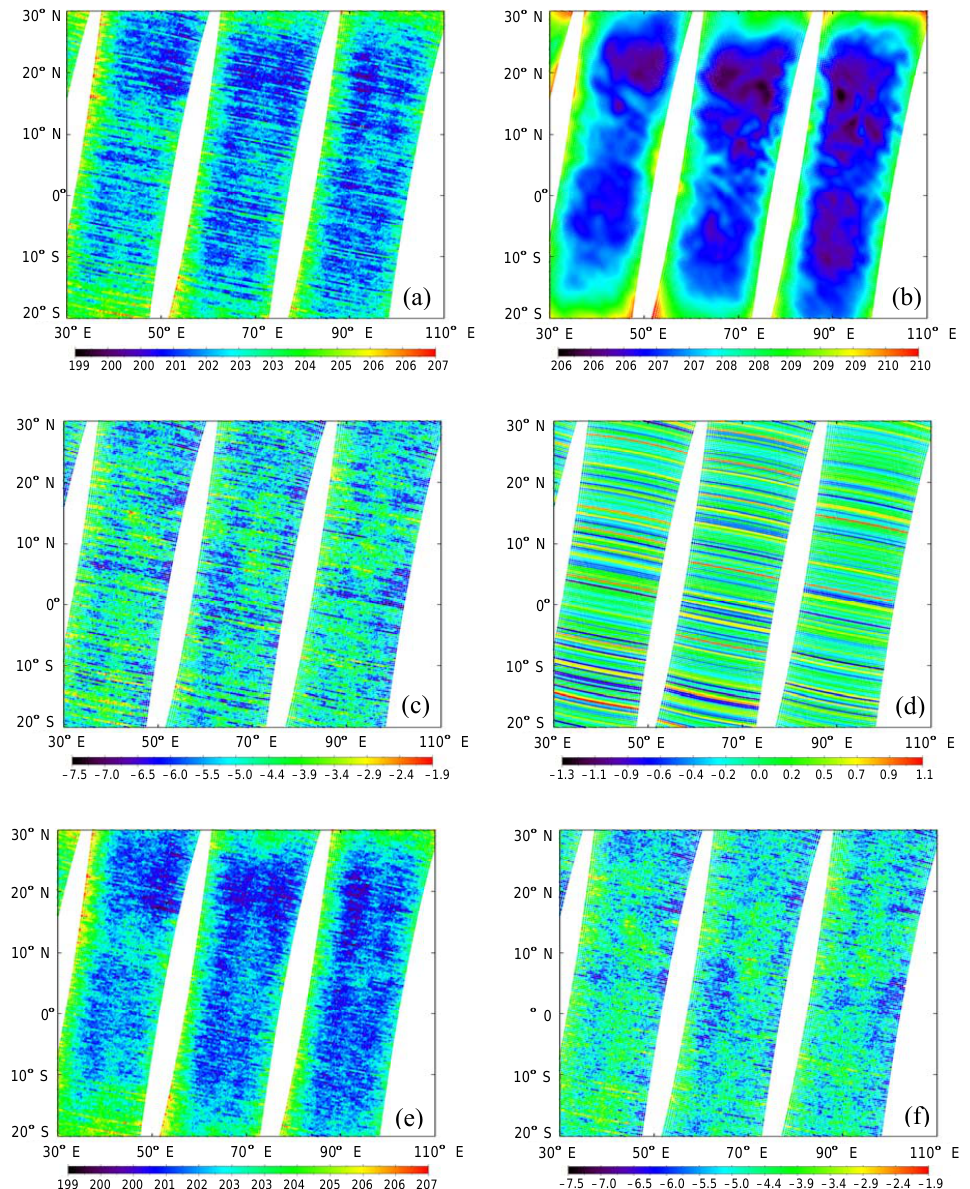
Figure 3. Distribution of (a) observed and (b) model simulated brightness temperature, (c) O-B, (d) striping noise, (e) observed brightness temperature and (f) O-B after removing the striping noise from FY-3C MWTS-2 channel 8 during 03:00–15:00UTC 1 July